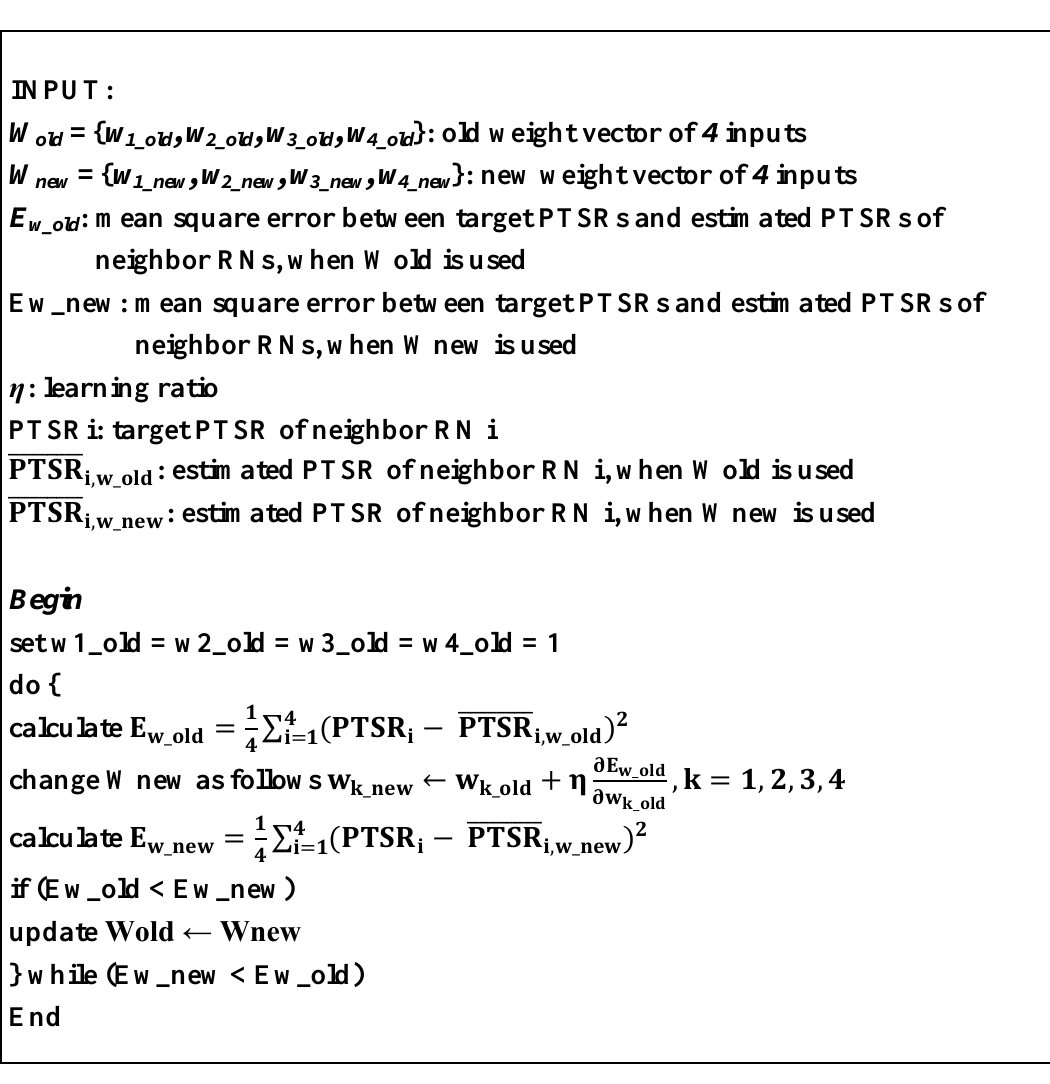
Figure 4. Training algorithm of the cost